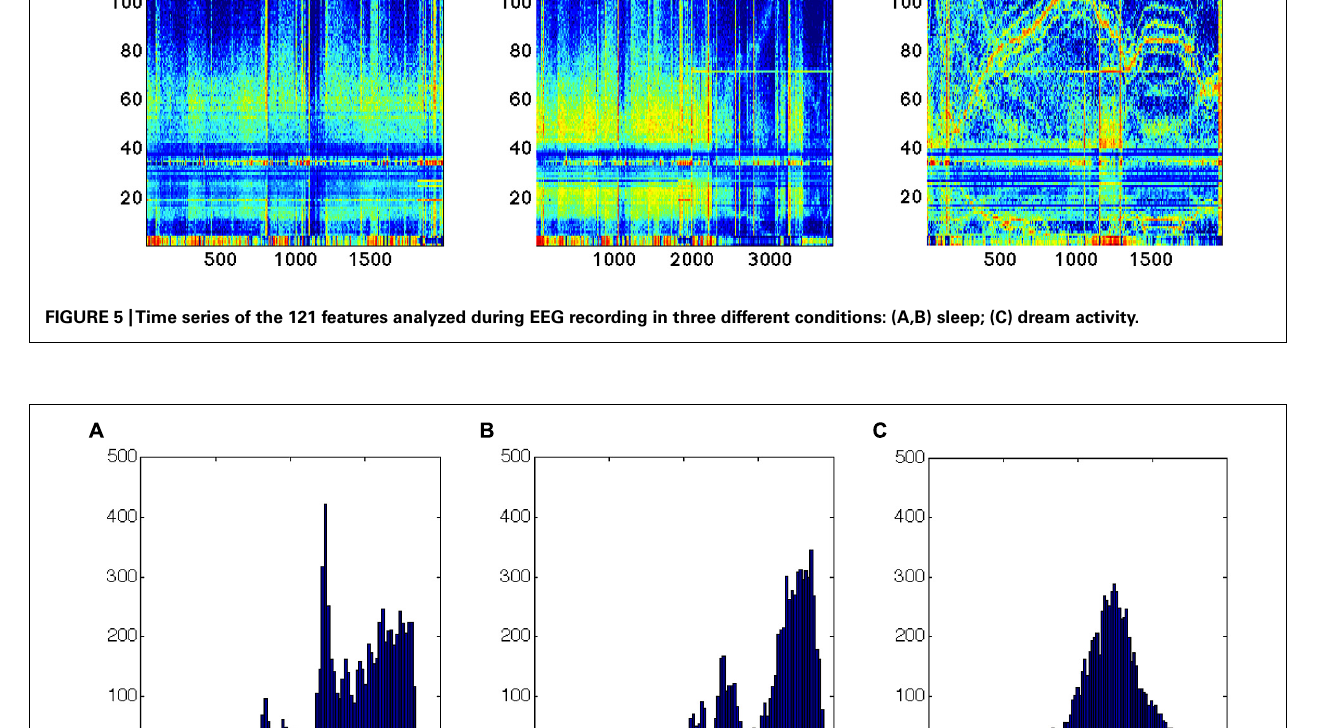
FIGURE 6 | Correlation coefficients distribution (over the whole time series of each experiment) as in Figure 5: (A,B) sleep; (C) dream activity. It can be easily seen that the histograms have similar shapes (in terms of